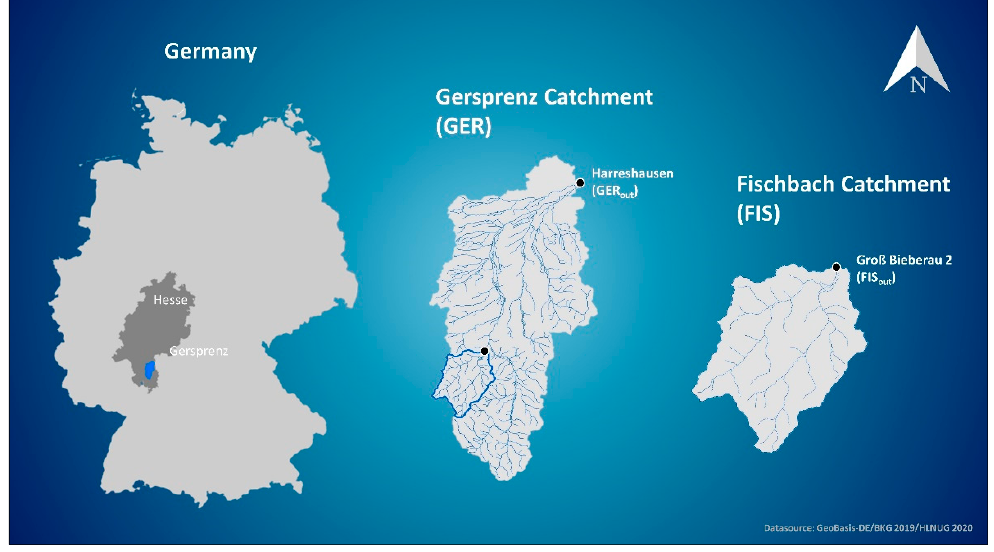
Figure 1. Field laboratory located in the federal state of Hesse in Germany.